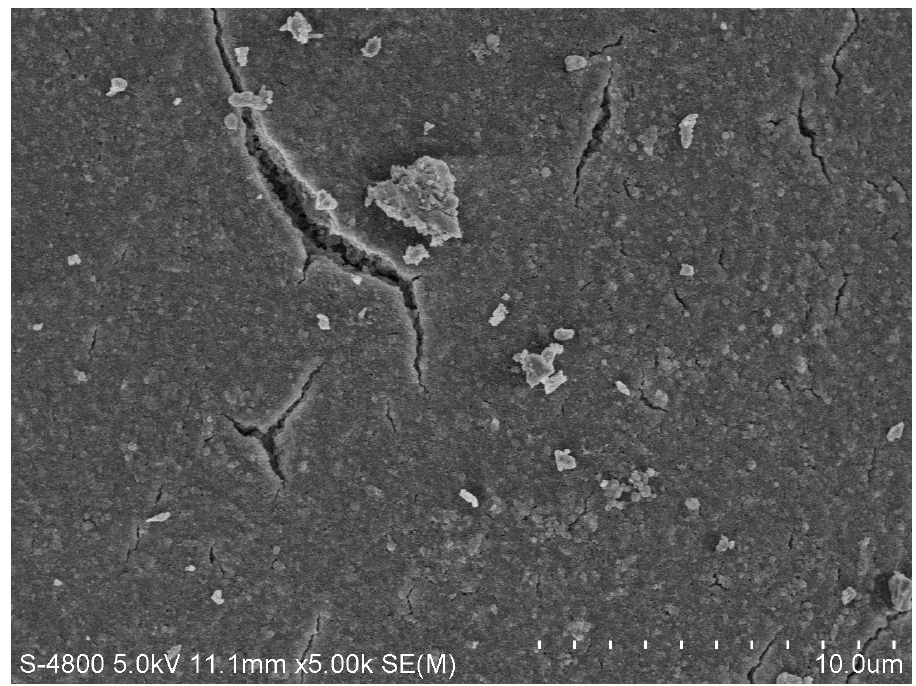
Figure 7. Photograph of the ZrO membrane with continuous ultrasound after filtration of 2 the TBL(with continuous ultrasound), magnification 5,000×.